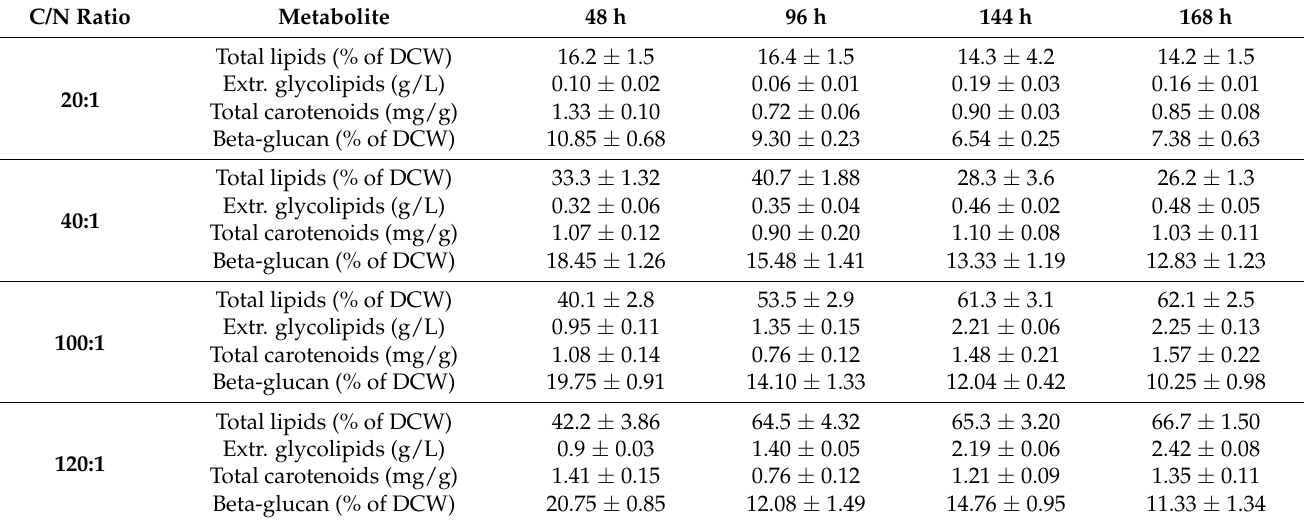
Table 8. Composition of yeast biomass during growth under different C/N